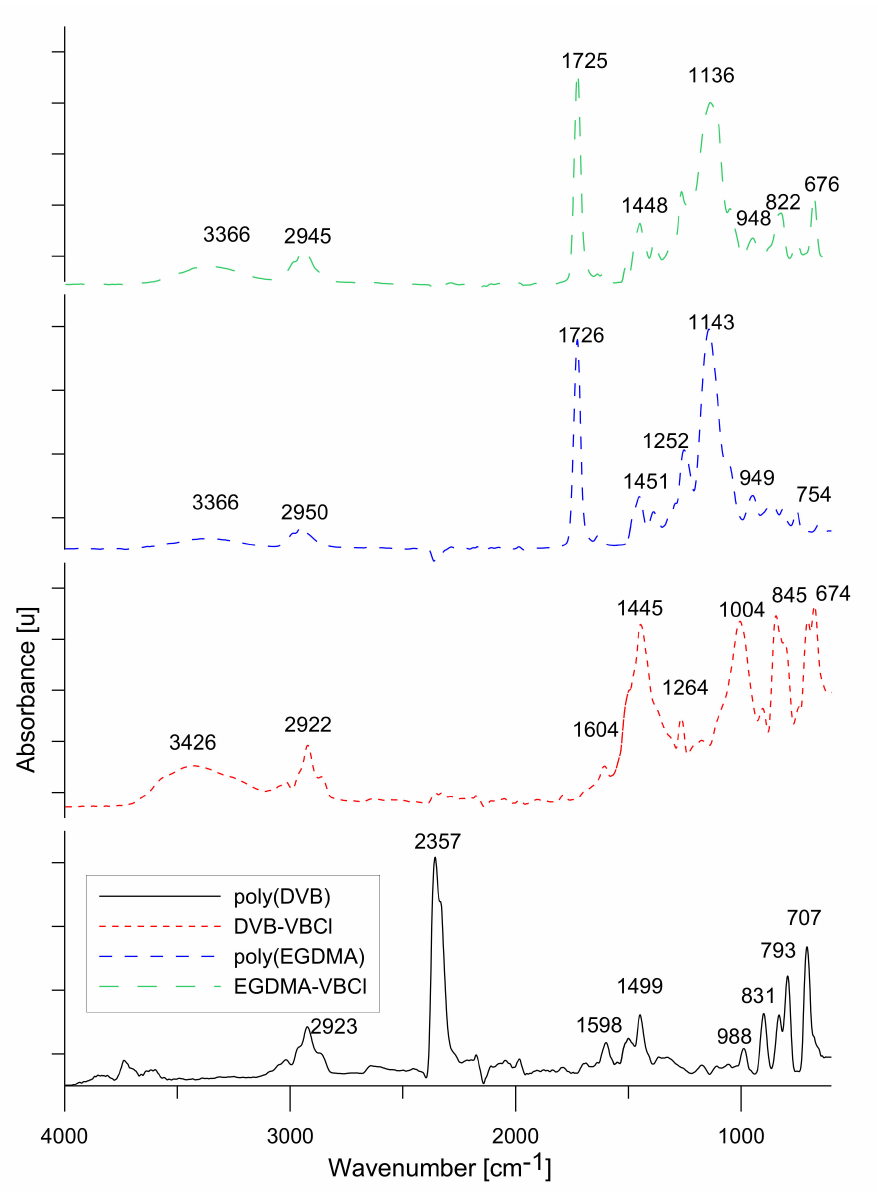
Figure 4. ATR-FTIR spectra of the studied